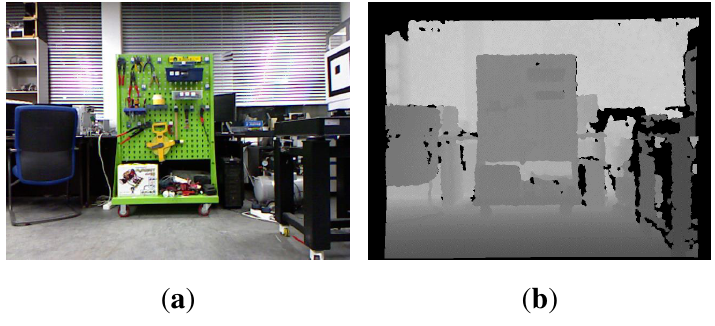
Figure 2. RGB-D sensor data. ( a ) RGB 2D image; ( b ) Per-pixel depth data.